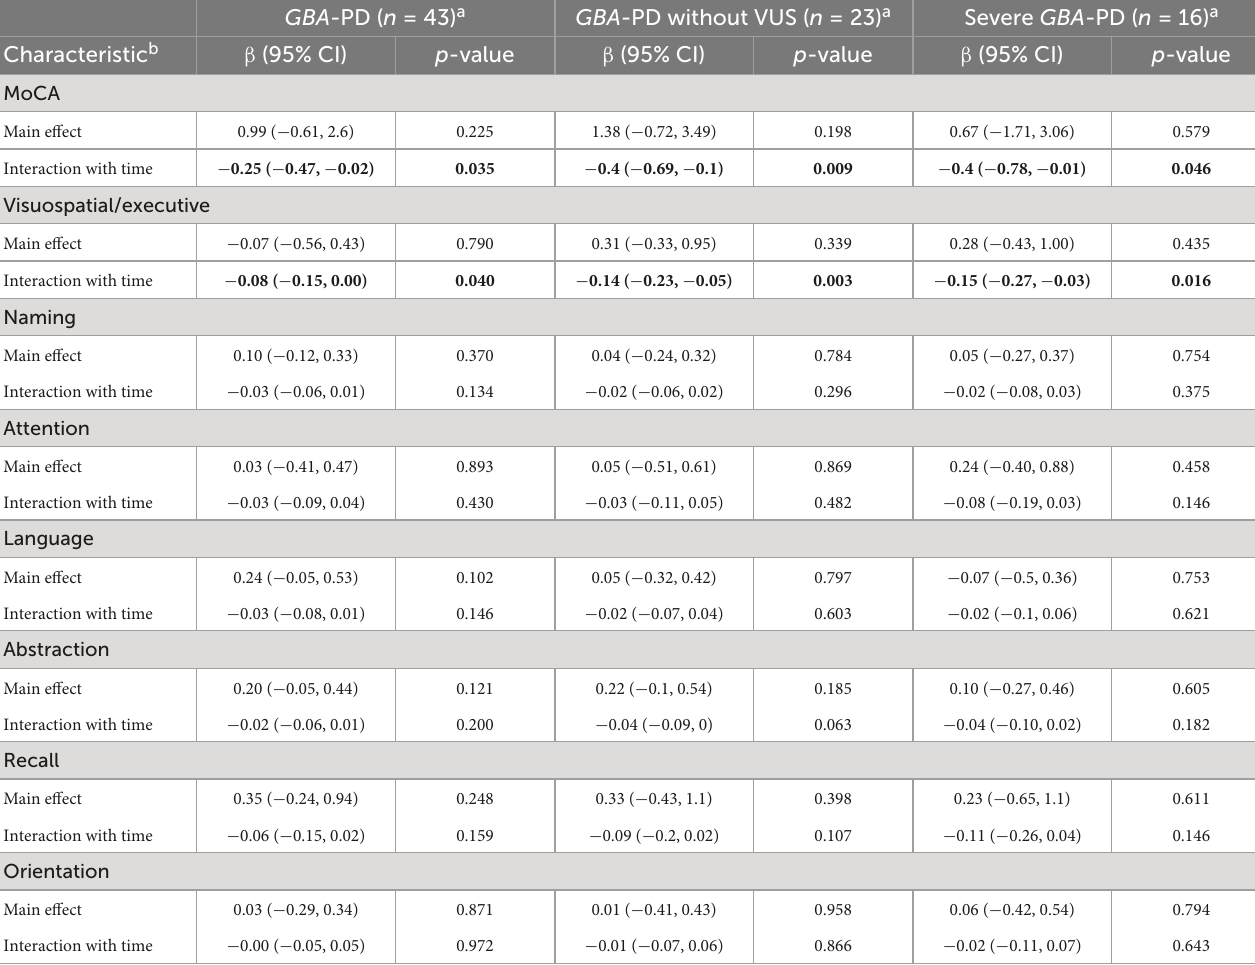
TABLE 3 Association between GBA carrier status and annual change in Montreal Cognitive Assessment (MoCA) scores and subscores using linear mixed-effects